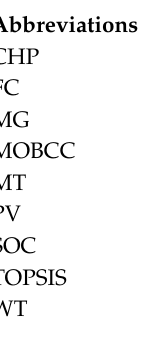
Figure 13. Results of heat power.